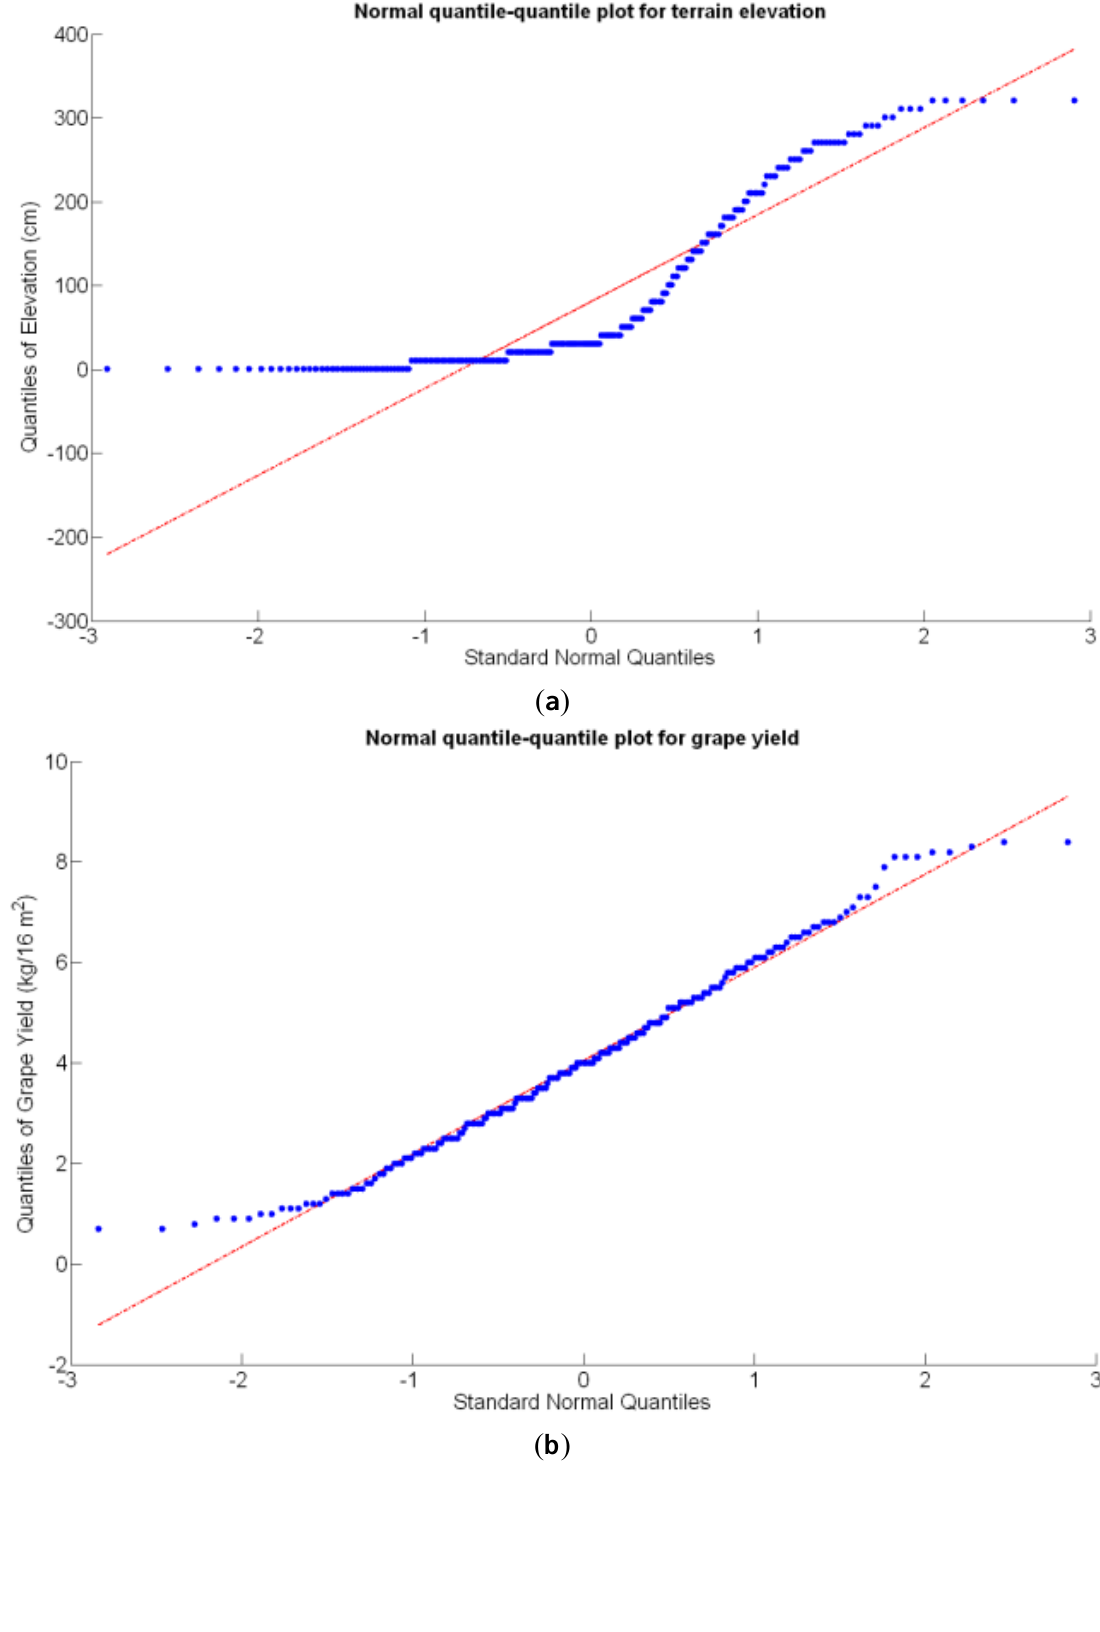
Figure 18. Normal quantile-quantile plots: ( a ) Terrain relative elevation (cm); ( b ) Grape yield (kg/16 m 2